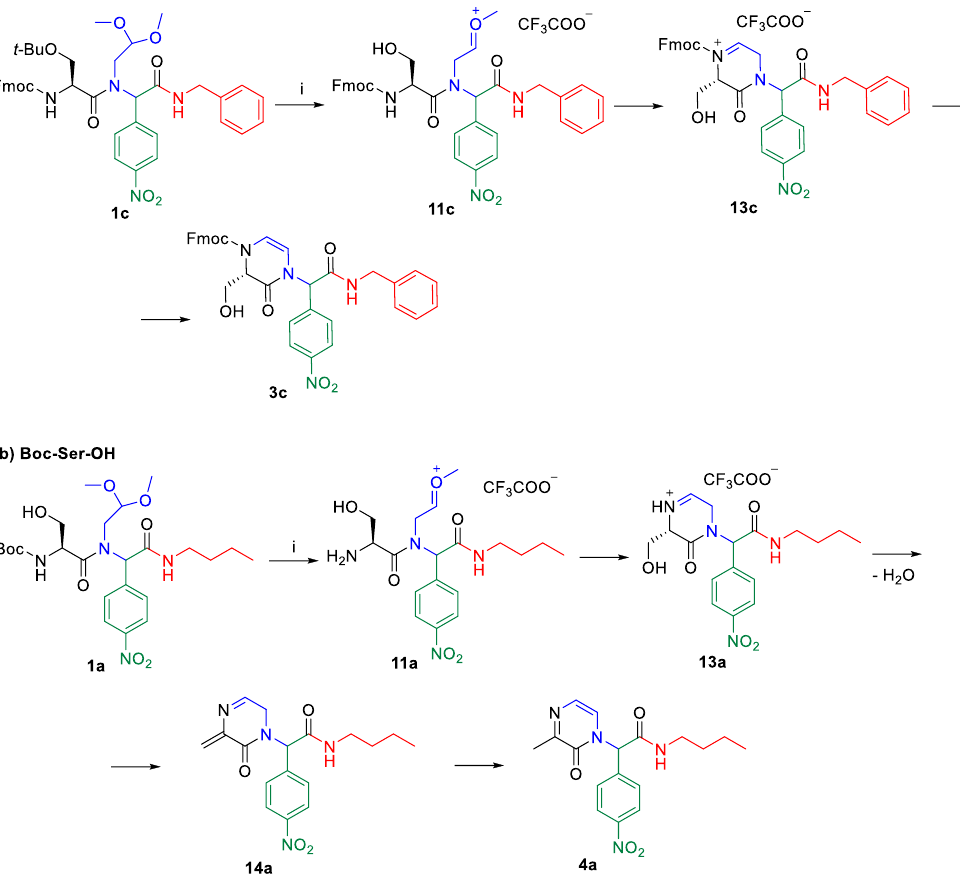
Scheme 3. Protecting group-dependent cyclization outcome. Reagents and conditions: (i) 50% TFA/CH 2 Cl 2 , rt, 16 h.